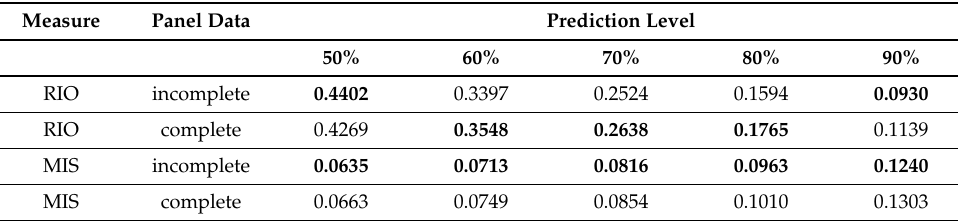
Table A14. Comparison of RIO and MIS for weekly S&P500 log-returns based on the out-of-sample period from 30 December 2005 until 5 February 2016. Measure Panel Data